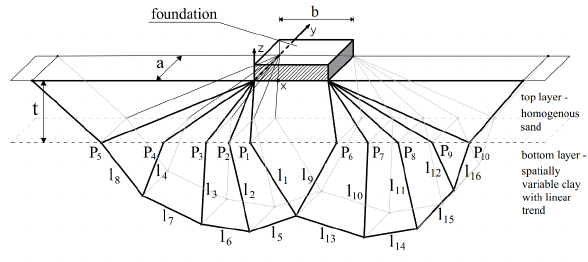
Figure 2: Failure geometry for two-layered soil for the probabilistic case. The indicated points and lengths are used to determine the failure